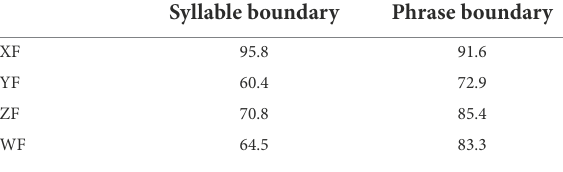
TABLE 4 The percentage of creaky L tone in different focus and boundary conditions